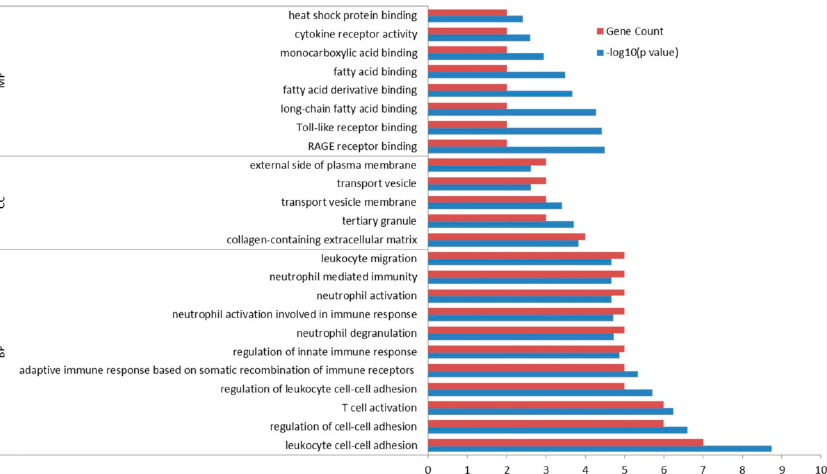
Figure 4. GO enrichment analysis of the common 14 up-regulated differentially expressed genes (DEGs) in both pterygium and primary Sjögren Syndrome (pSS) samples. MF: molecular function. BP: biological processes. CC: cellular component. The red bar represents the number of DEGs corresponding to the GO analysis term. Blue bar represents − log10 ( p value). ( p <